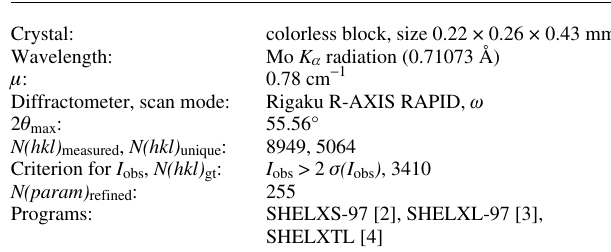
Table 1. Data collection and handling.